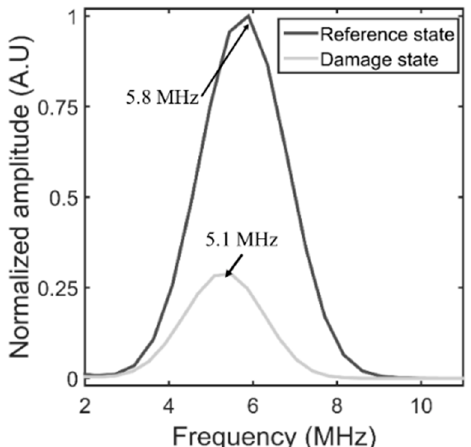
Figure 5. The frequency spectrum of guided wave in reference and damaged sensors using chirp excitation.